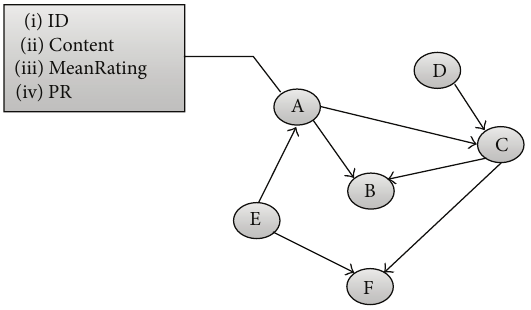
Figure 2: Example of Directed Graph of